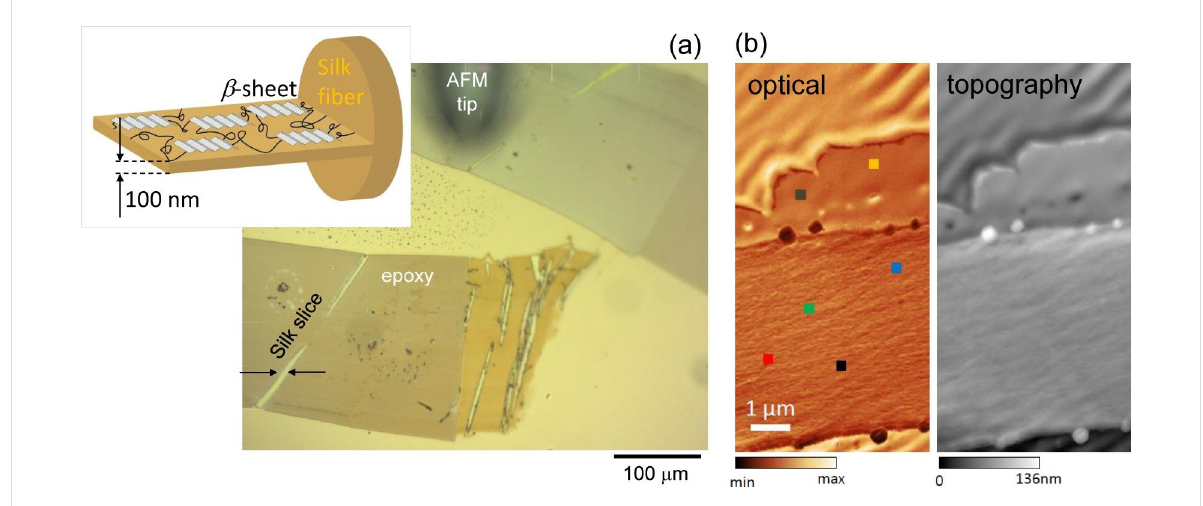
Figure 4: (a) Far-field optical image of longitudinal slices of white silk embedded in an epoxy sheet. The inset shows schematics of a lateral silk slice composed of β -sheets interconnected with α -coils and amorphous segments. (b) Optical and topographic images of the silk slice shown in (a) measured with scattering near-field microscopy (SNOM; neaspec). Markers in optical image indicate locations where spectra were acquired.